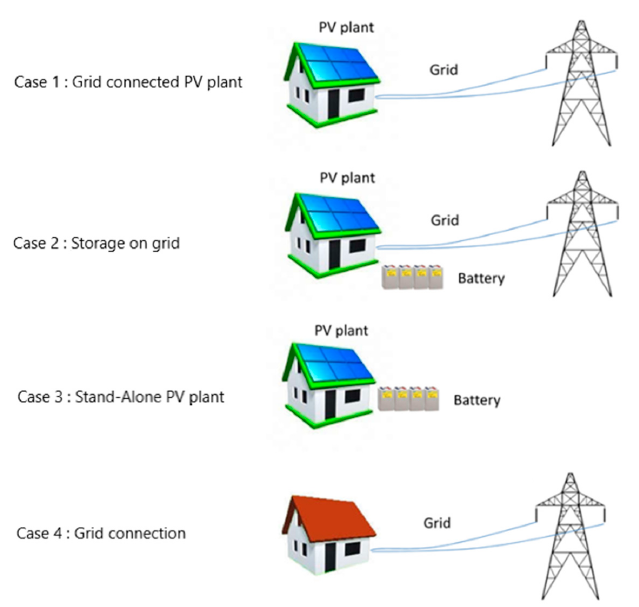
Figure 1. Assessed patterns of power supply.